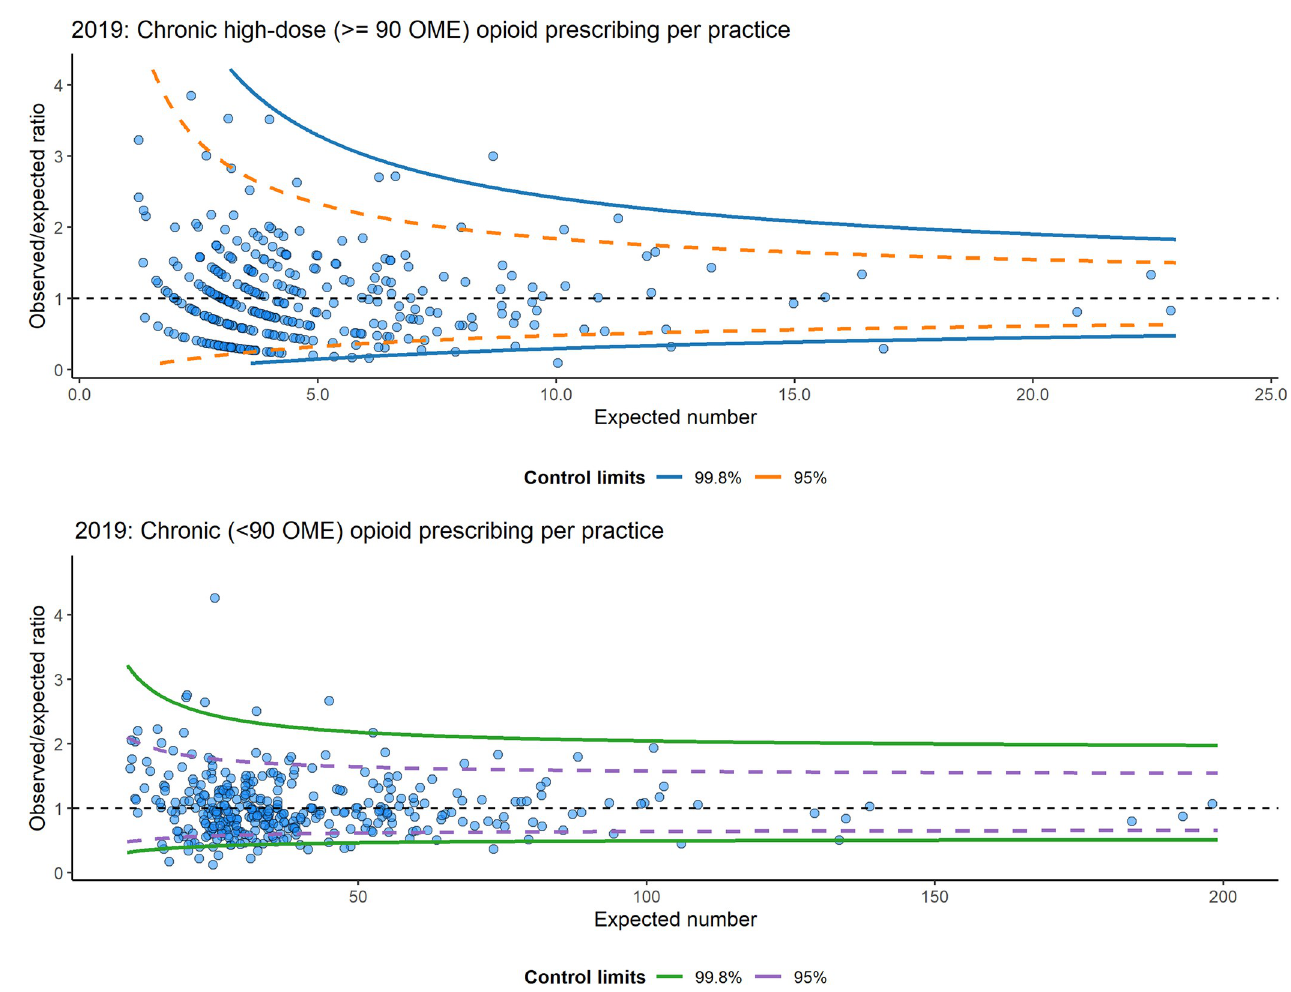
Fig 1. Funnel plots for both outcomes for 2019. Control limits for the outcome chronic < 90 OME were corrected for overdispersion. The horizontal black dotted line (O/E = 1) represents the target value where the observed proportion equals the expected proportion based on case-mix. Each dot represents a single practice. Variation between practices that lie between the 95% control limits is considered to be caused by random variation. Practices above or below the 95% control limits are considered outliers and were categorised as either high or low prescribers, respectively.